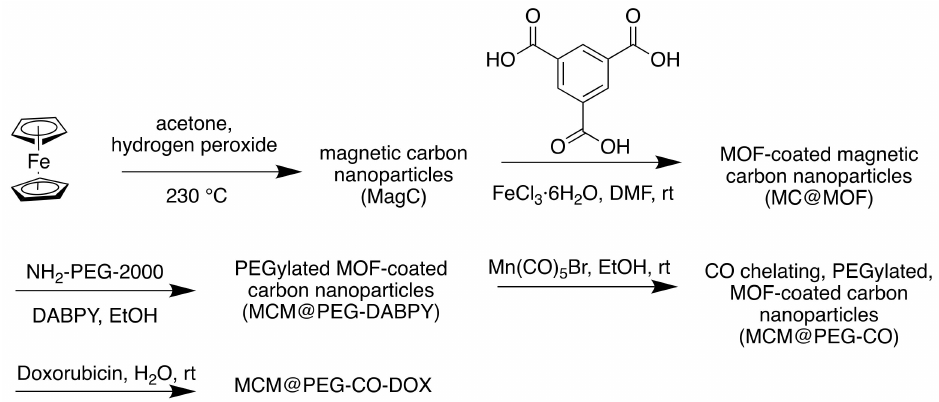
therapy and tumour